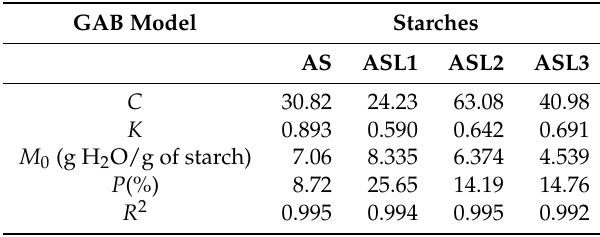
Table 2. Parameters of GAB model for modeling the moisture adsorption isotherms of starches at 25 ◦ C GAB